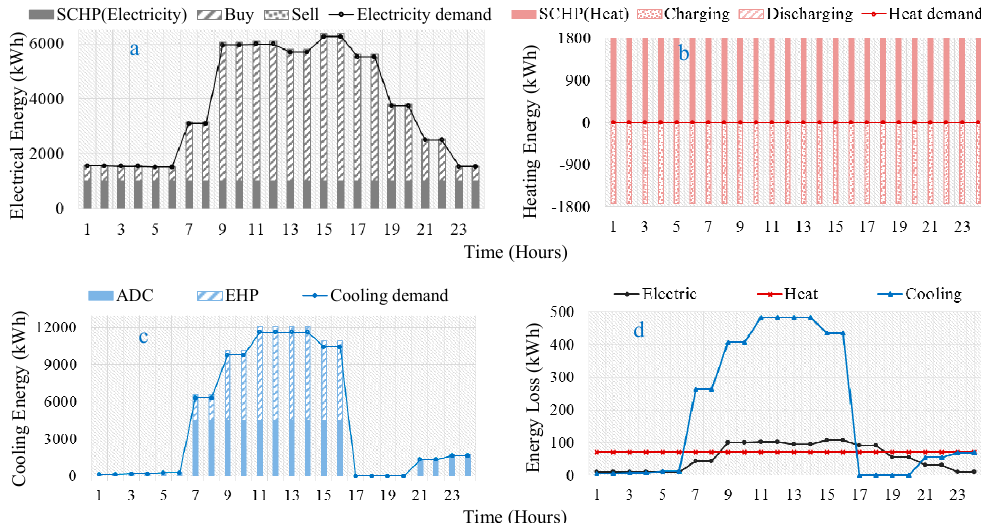
Figure 8. Energy balancing of BMG3 in summer season: ( a ) electrical energy; ( b ) heating energy; ( c ) cooling energy; and ( d ) energy loss.